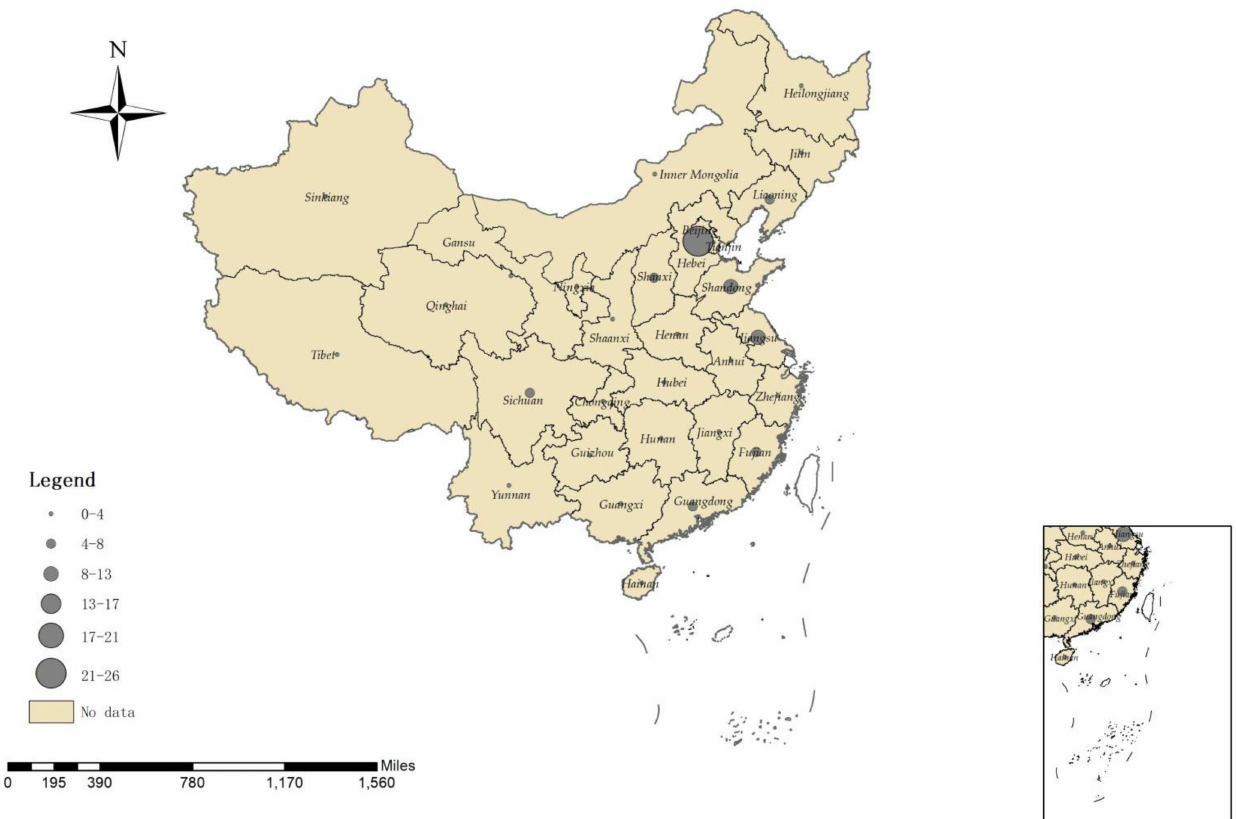
Figure 3. Steel mill distribution in China (Reproduced according to ref. [90]).